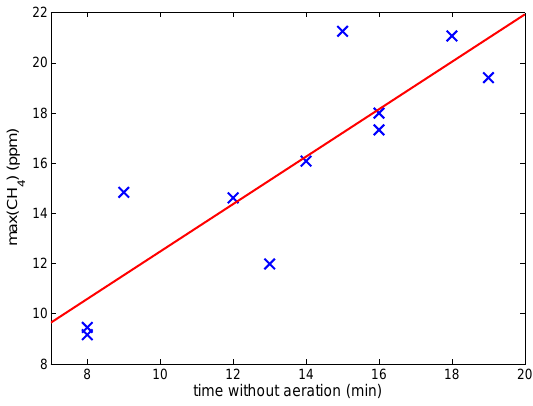
Figure 8. Methane maxima reached during the night chamber mea- surement vs. time without aeration. Blue are measurements; red is the linear fit.